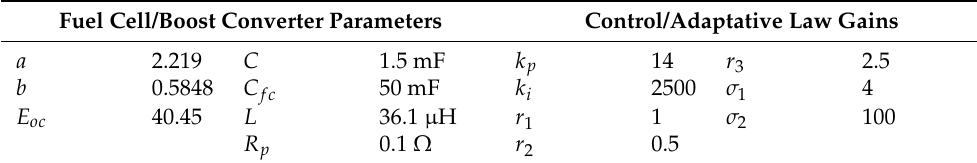
Table 1. Parameters and gains of the adaptive E-L-PBC-based control fuel cell